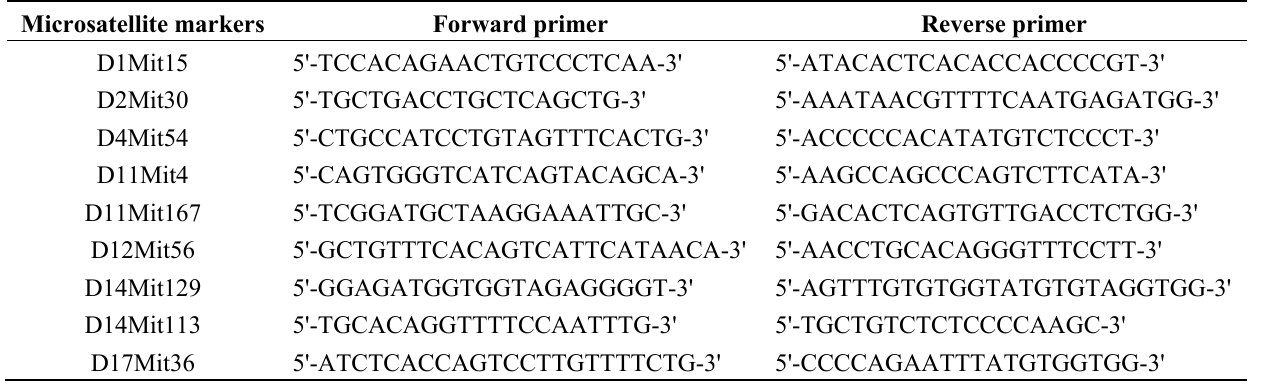
Table 6. The primer sequences of microsatellite markers used in the present experiment. Microsatellite markers